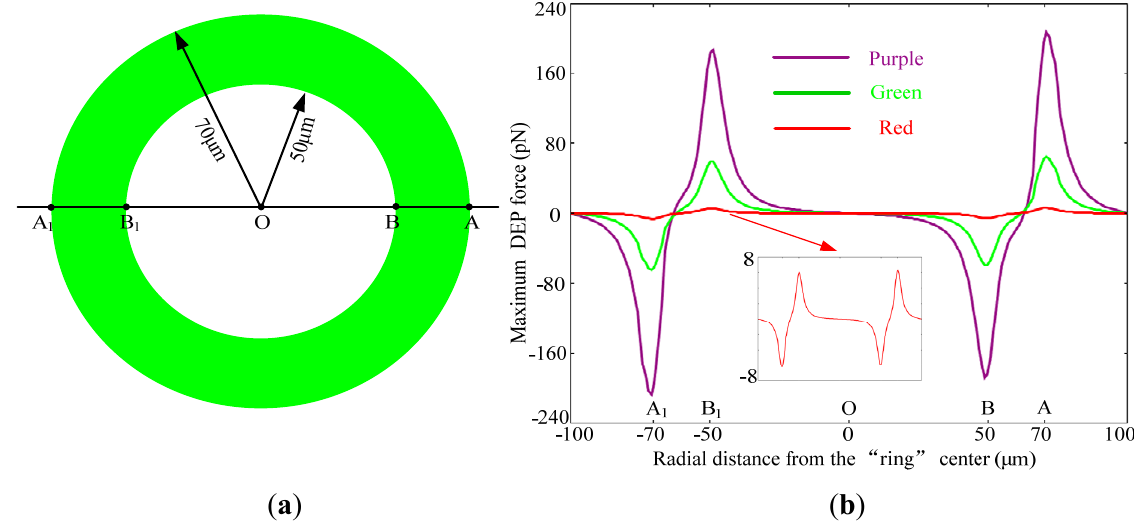
Figure 3. ( a ) Incident light ring geometry; ( b ) Maximum DEP force for a 10 μ m polystyrene bead with respect to different light colors. To obtain the numerical results, we have used the experimental dark conductivity of the a-Si:H film of 1 × 10 − 11 S/m (measured by a Keithley 2410 source meter) and liquid conductivity of 9 × 10 − 3 S/m (measured by a Cond 3110 conductivity meter). The estimated photoconductivity values of the a-Si:H at the respective wavelengths from Table 1 are used in the simulation. The frequency of the applied AC potential is 30 kHz.